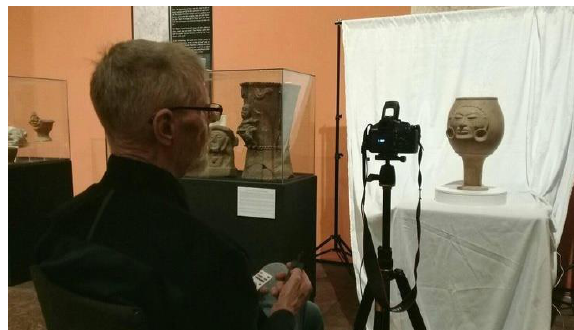
Figure 17. Photogrammetric capture process of the exhibited pieces by using the ComXim Professional 360 Degree